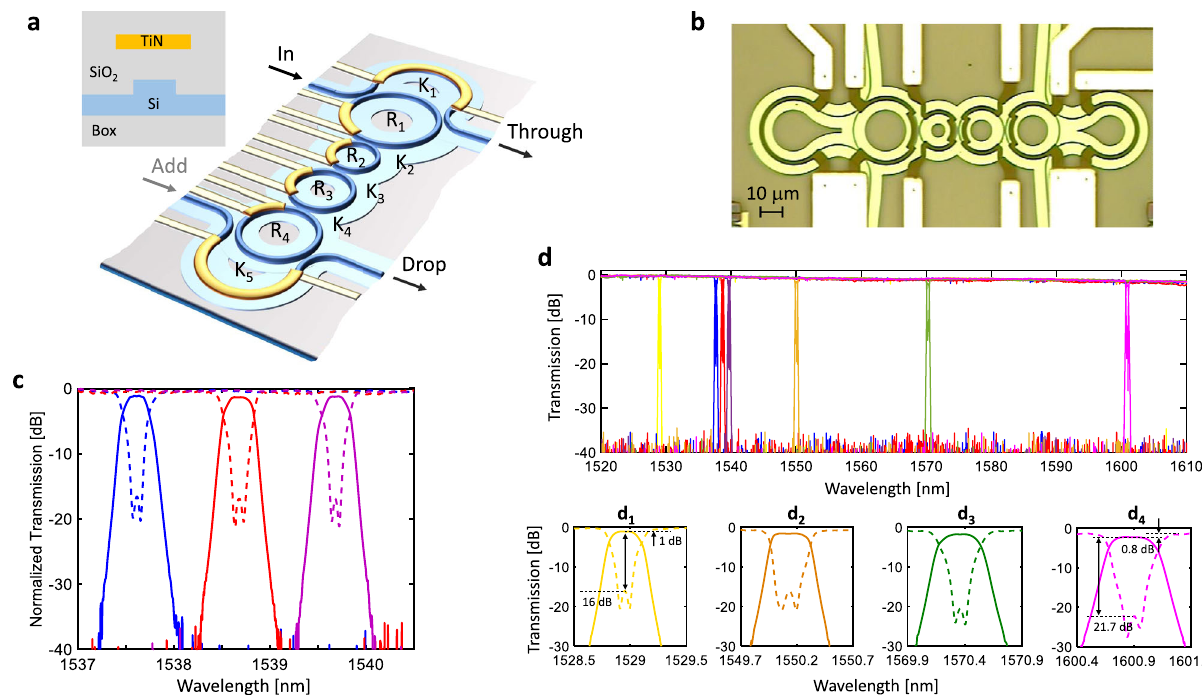
Fig. 1 FSR-free fi lter. a Schematic of the 4th order MRR Vernier fi lter with MZI tunable couplers. TiN heaters, controlled individually, are placed 700 nm above the waveguide core; b microscopic picture of fabricated device; c Drop (solid) and Through (dashed) port transfer function of the fi lter tuned at 3 channels around 1538 nm. The fi lter has about 40 GHz bandwidth with more than 30 dB rejection at 50 GHz from the center of the passband. d Frequency response of the fi lter tuned to 7 different channels across a 90-nm-wide wavelength range. FSR-free operation is observed for all the tuning con fi gurations. Across the entire wavelength range, the in-band insertion loss at the Drop port (with respect to the off-band Through port transmission) is <1 dB and the in-band isolation at the Through port (with respect to the in-band Drop port transmission) is higher than 16 dB.